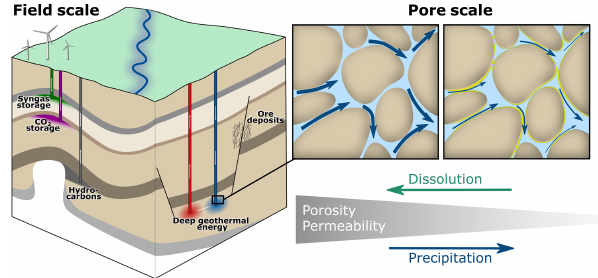
Figure 1. The geological subsurface is of essential relevance for a broad range of applications. Geochemical processes alter the mi- crostructure of rocks, which in turn affects their hydraulic behaviour on the macro scale, and thereby governs the evolution of geological subsurface